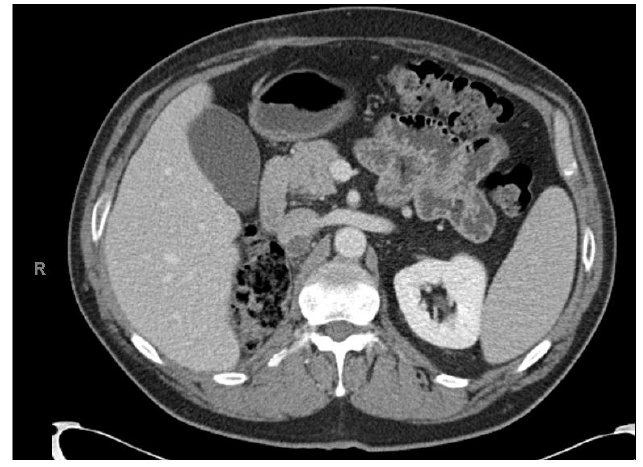
FIGURE 5. CT 6 months postsurgery showing a stable nonenhancing mass posterior to the